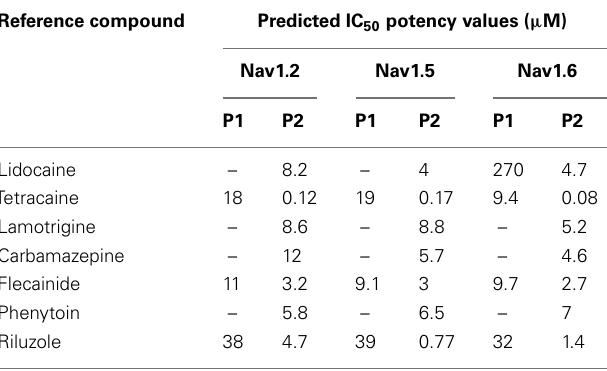
Table 3 | Potency values for reference Nav inhibitors as determined with the 2-pulse protocol.